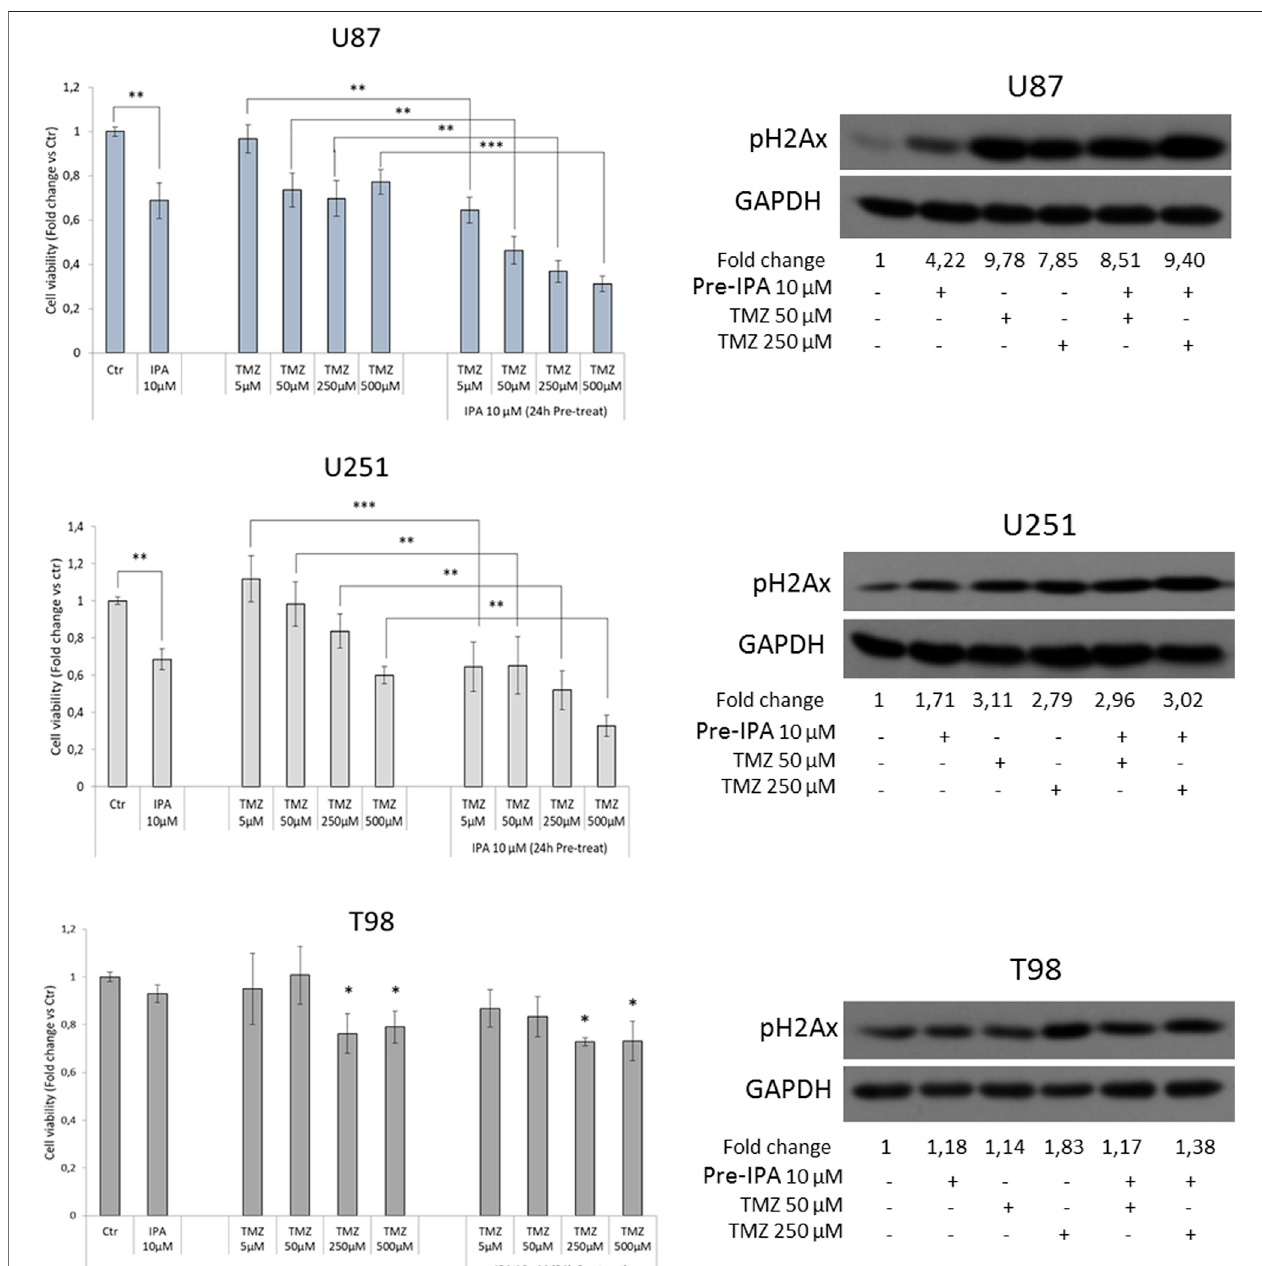
FIGURE 3 | IPA sensitizes GBM to TMZ. GBM cells were exposed to IPA 10 µM or vehicle (DMSO) for 24 h. After the incubation, the medium was removed and replacedwithafreshonecontainingtheindicatedconcentrationsofTMZortherelativevehiclealone.MTTassaywasusedtoassesscellviabilityafter72 h,expressedas the mean ± SD of three independent experiments. ** p < 0.01, *** p < 0.005 in U87 and U251, * p < 0.05 vs. control in T98 (histograms on the left). On the right, representative western blot and relative densitometric analysis (fold change vs. control) of phosphorylated histone H2Ax (S139), in U87, U251, and T98 cells subjected to the same experimental conditions of the vitality assay (panel on the